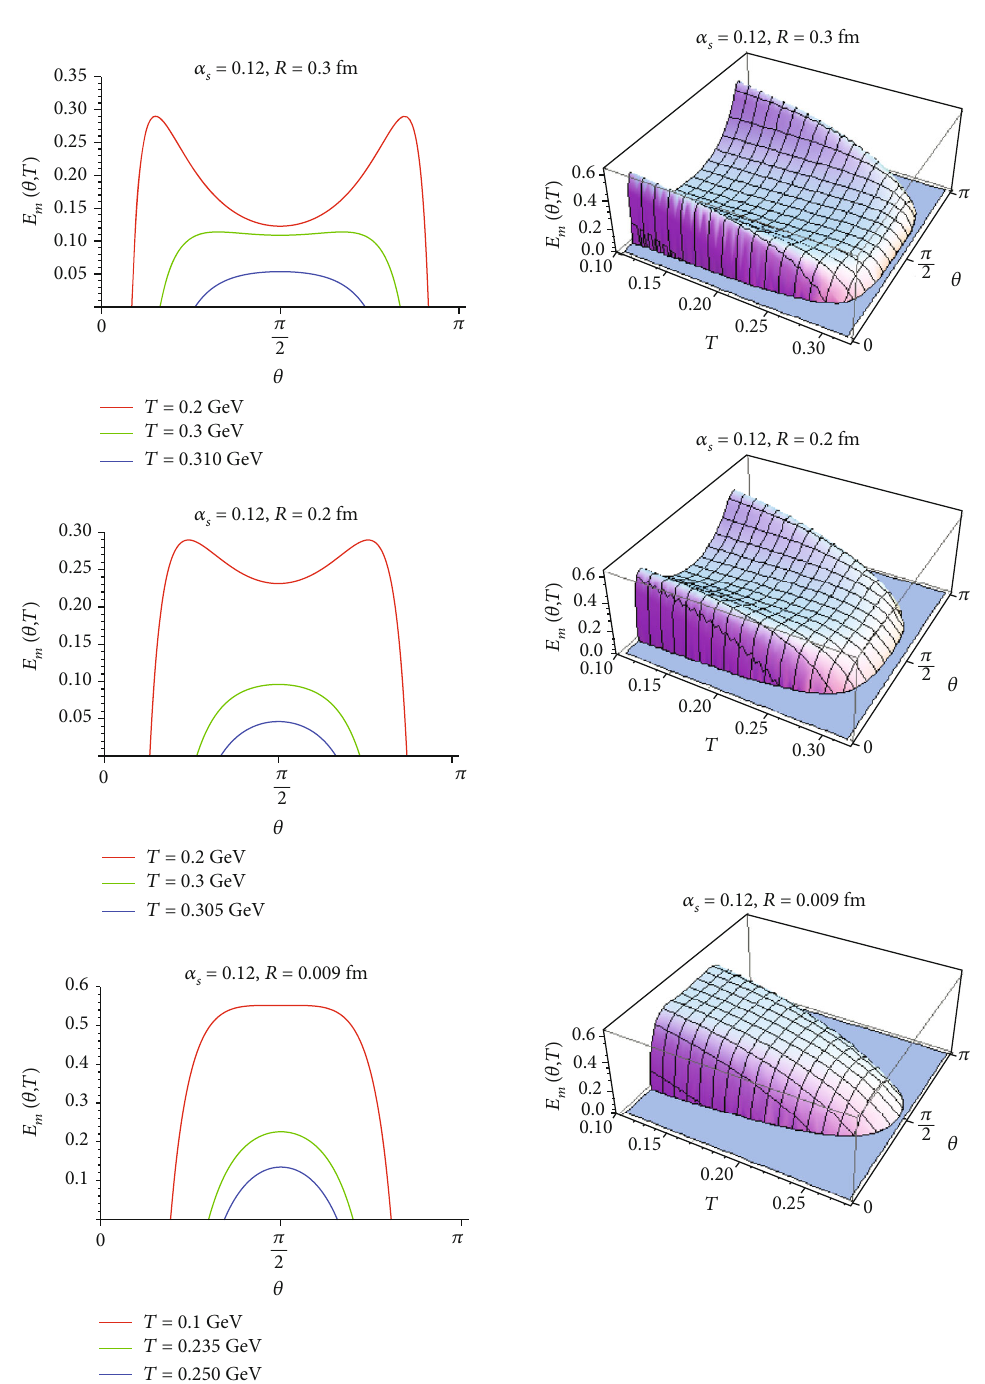
= 0 : 12 ð θ , T Þ at α m s